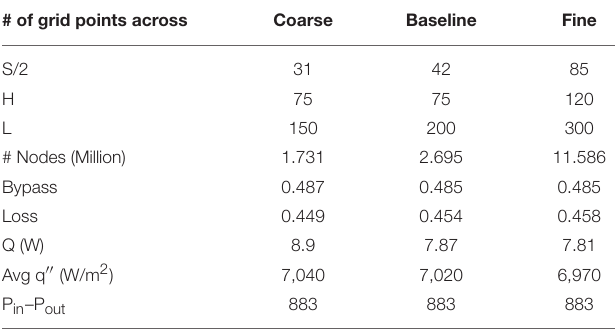
TABLE 2 | Grid-sensitivity study.